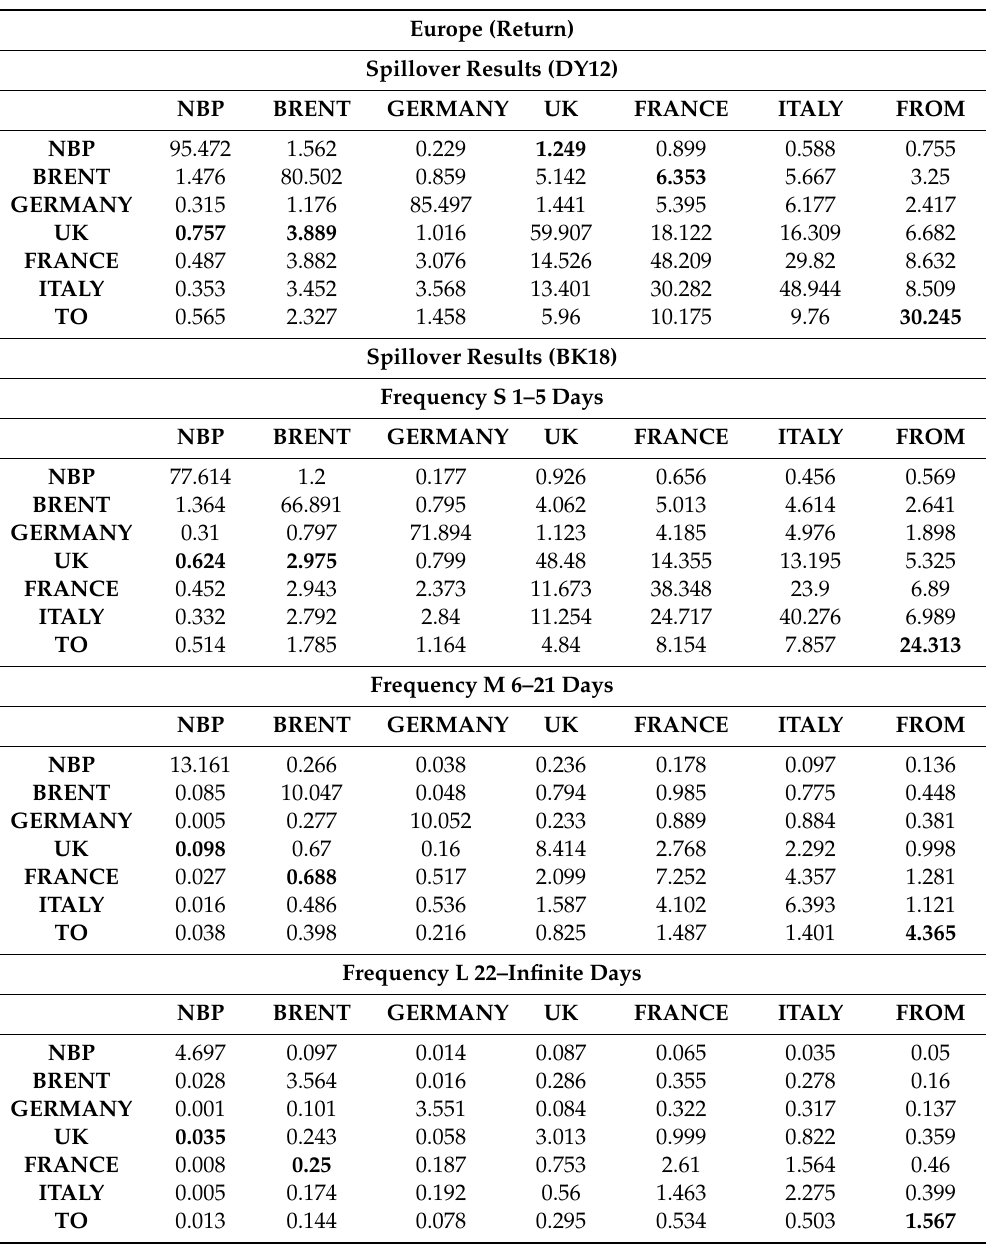
Table 5. Return spillover table of DY (2012) and BK (2018)